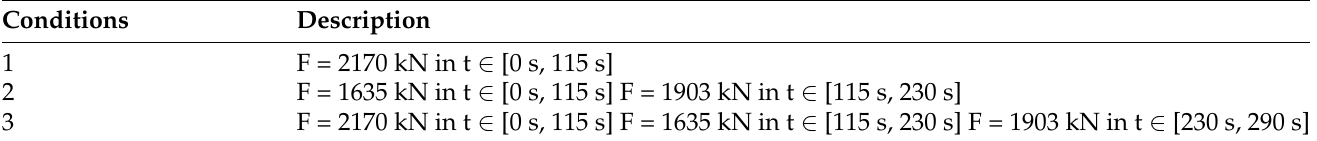
Figure 8. Field layout of the stay cable in the full-scale model experiment. Table 2. Designed conditions information of the full-scale experiment.